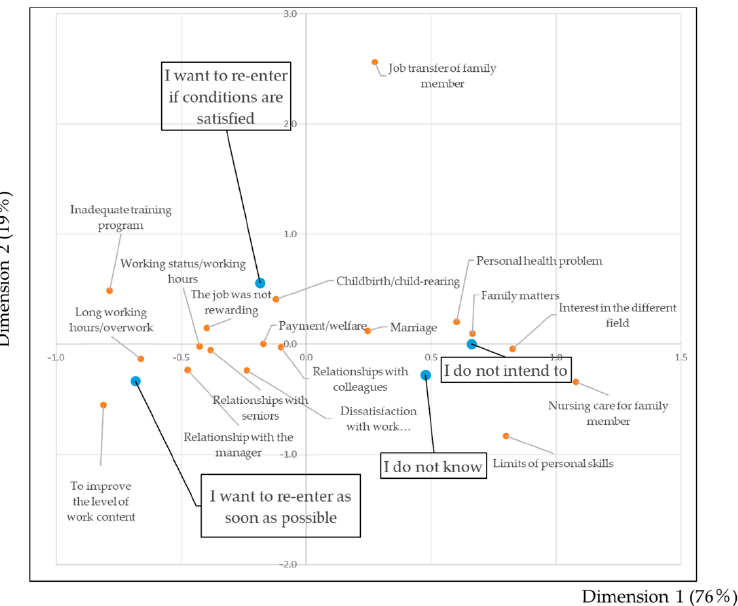
Figure 1. Biplot diagram showing the willingness to re-enter and the reasons for leaving jobs. The blue circles indicate the level of willingness to re-enter: “I want to re-enter as soon as possible,” “I want to re-enter if conditions are satisfied,” “I do not intend to,” and “I do not know.” The red circles show 18 reasons for leaving jobs. The closer the items are to each other, the higher the association between items.